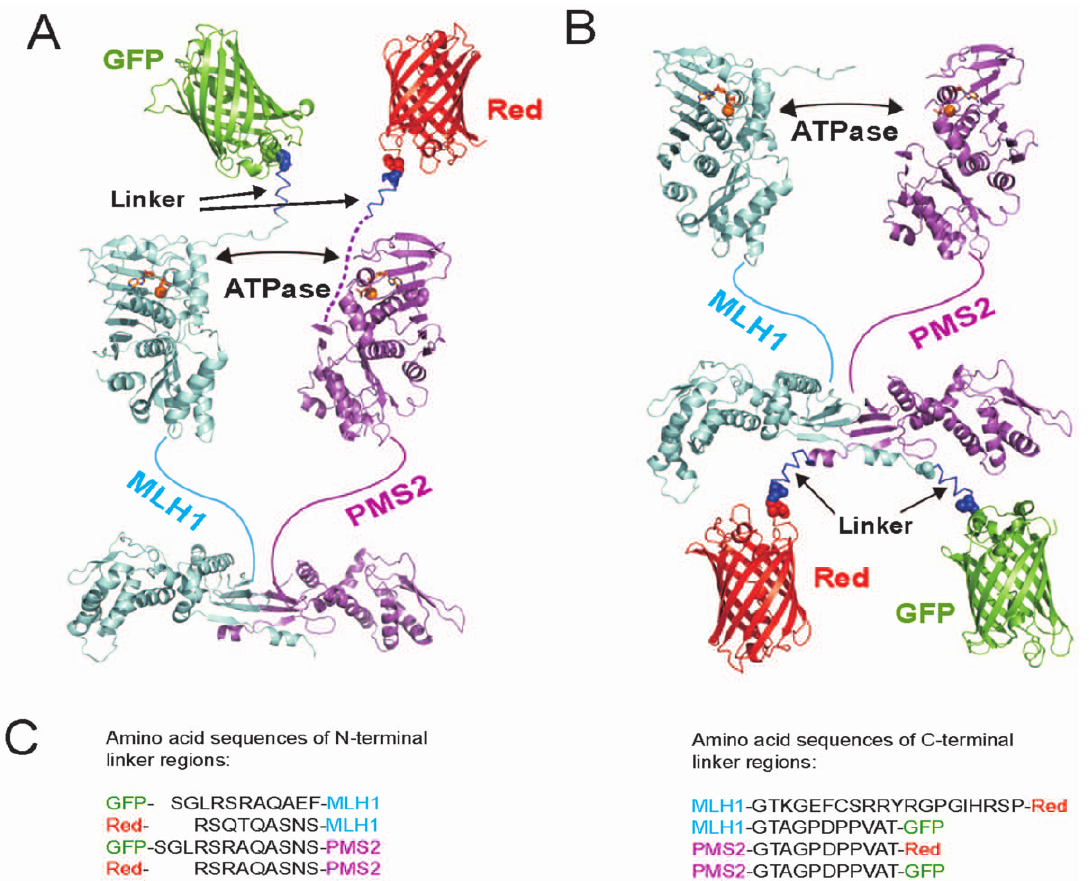
Figure 5. Putative three-dimensional structure models of fluorescent labeled MutL a . Using PyMol (Warren DeLano, http://www.pymol.org/), GFP or Red fluorescent proteins were attached to (A) N-termini of MLH1 and PMS2 or (B) C-termini of MutL a . C-terminal tags seem to hide the C-terminal region of MutL a and consequently might avoid DNA interaction. (C) Corresponding amino acid sequences of linker regions are shown. The dashed line between PMS2 and the N-terminal fluorescent tag illustrates a putative a -helix (unknown structure) of the first thirty amino acids of PMS2.